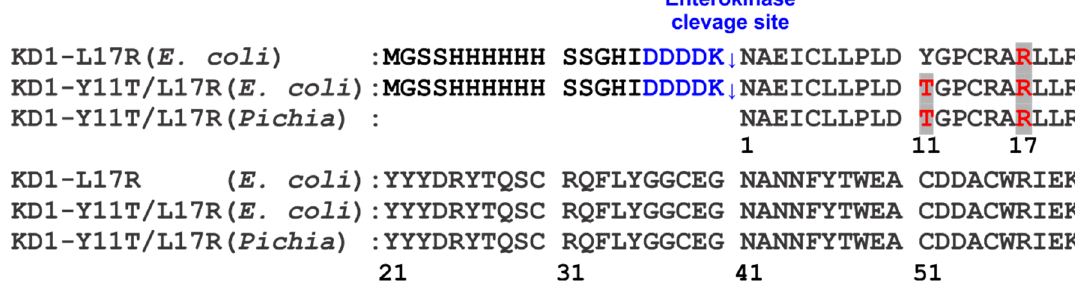
Figure 1. The expressed sequences of human TFPI-2 KD1 single mutant (KD1-L17R-K COOH ) in E. coli and double mutant (KD1-Y11T/L17R-K COOH ) in E.coli and Pichia pastoris . The down arrows indicate the enterokinase cleavage site introduced to remove the His-tag. The mutated residues Tyr11Thr and Leu17Arg are marked in red and the enterokinase cleavage sequence introduced is marked in blue. Residue 1 is numbered according to the BPTI-Kunitz domain numbering and corresponds to the amino acid 10 in the TFPI-2 Kunitz domain1